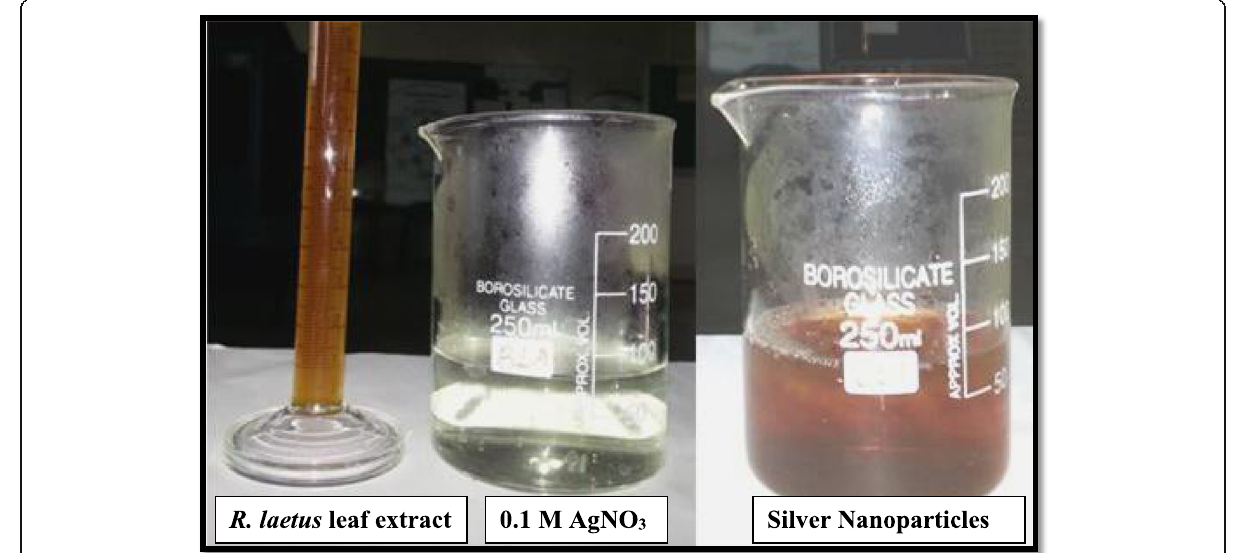
Fig. 1 Dark brown color of